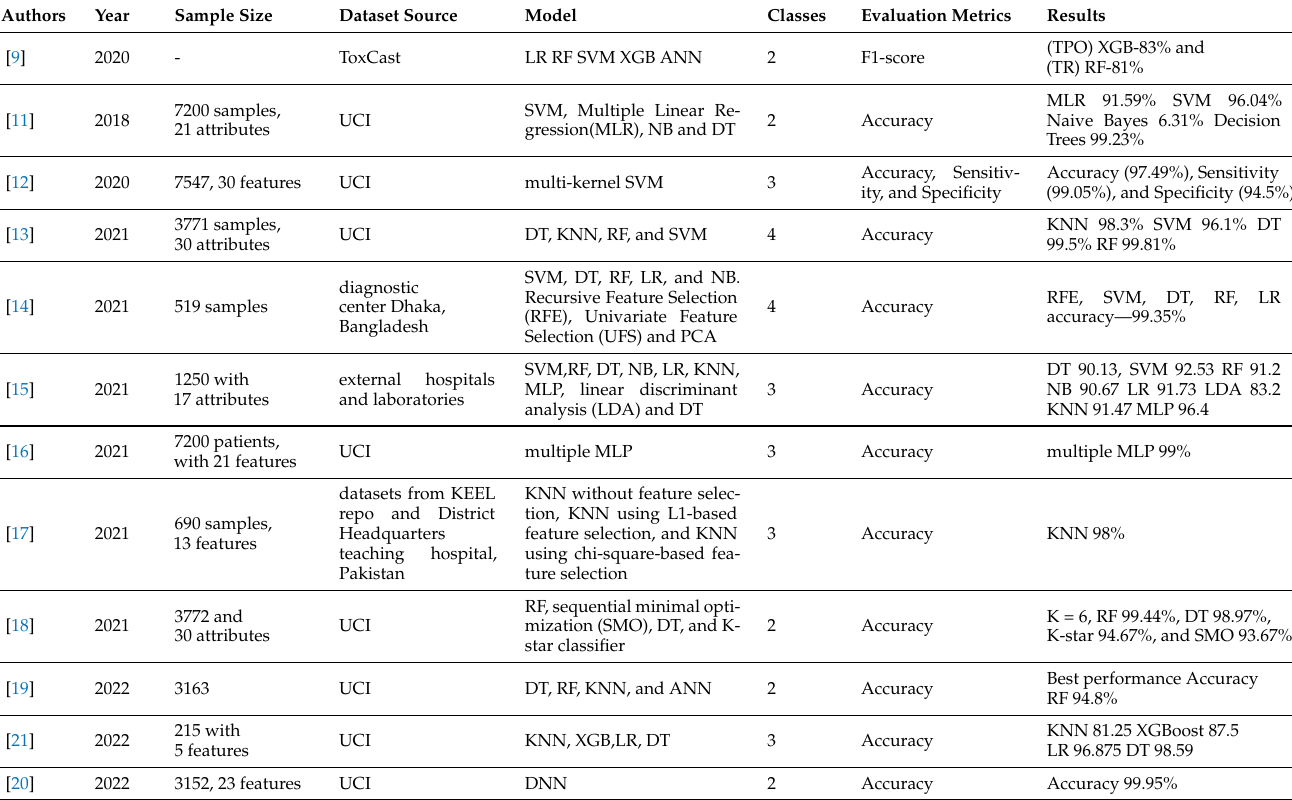
Table 1. Summary of the systematic analysis of the state-of-the-art thyroid disease